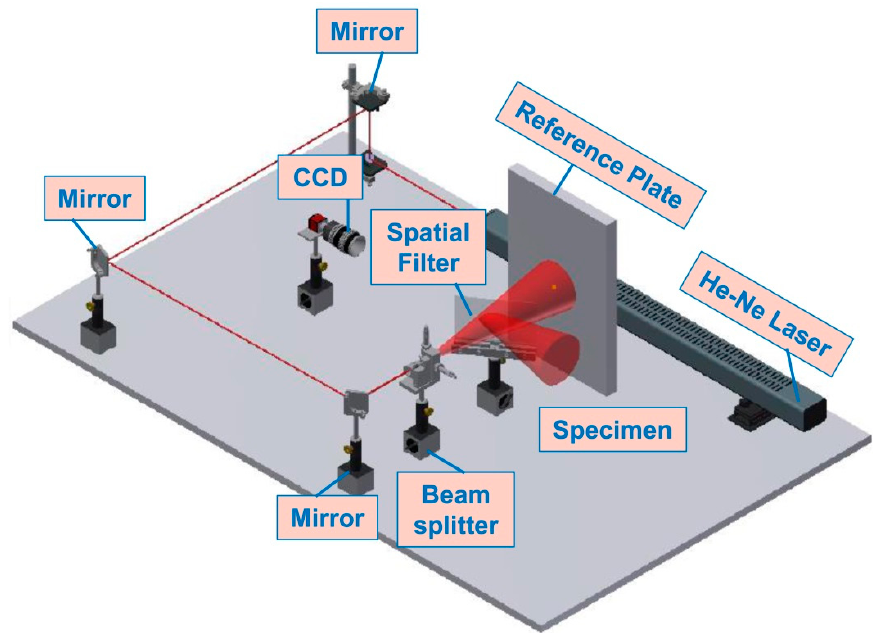
Figure 8. Schematic diagram of electron speckle pattern interferometry (ESPI).